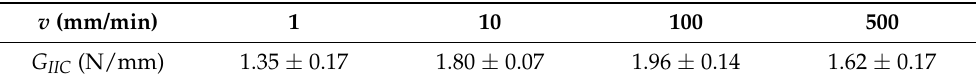
Table 2. Mode II interlaminar fracture toughness at various displacement rates, v .